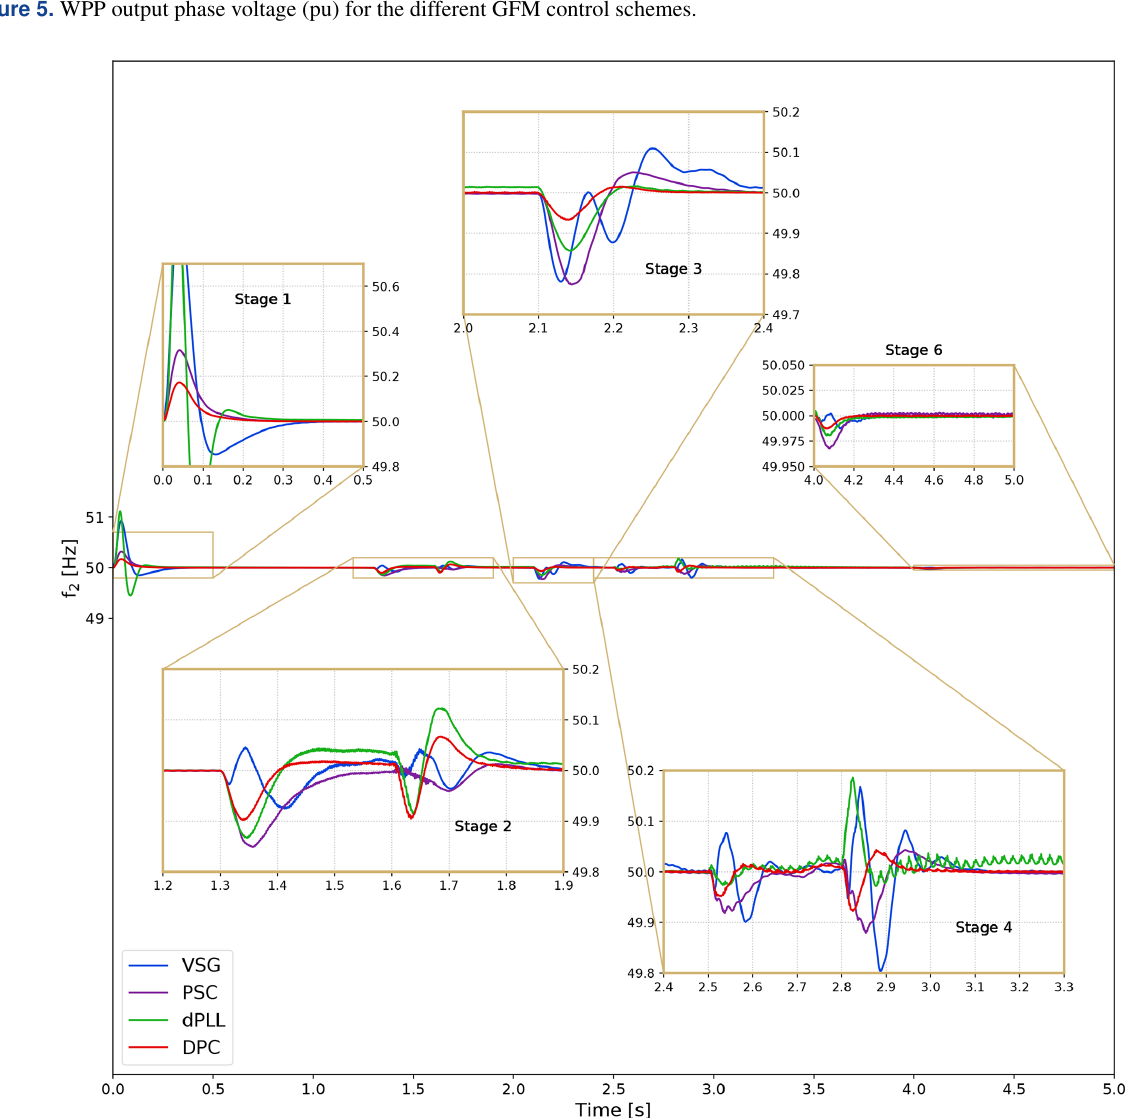
Figure 6. Frequency at offshore PCC-2 with zoomed insets to show transients in the different stages of the energization